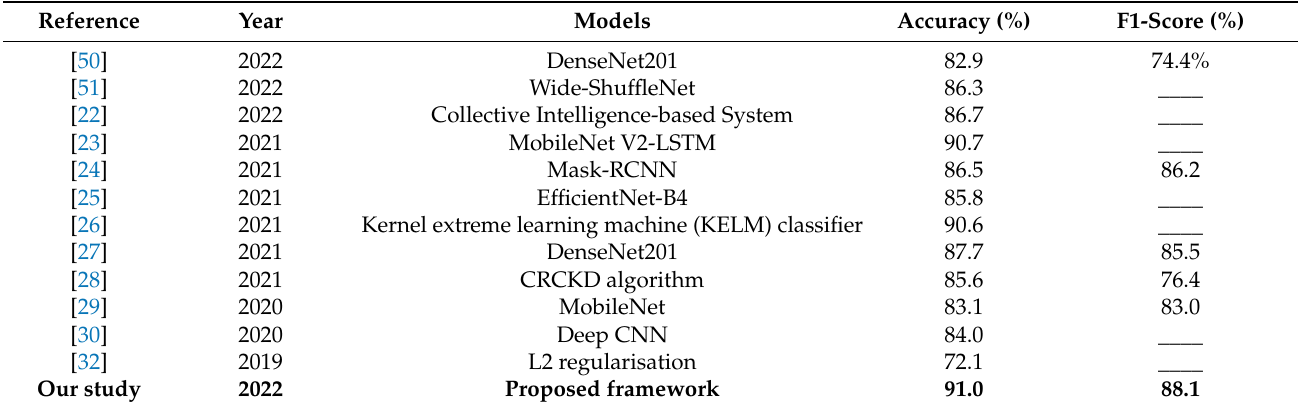
Table 5. Comparison of previous studies on the HAM10000